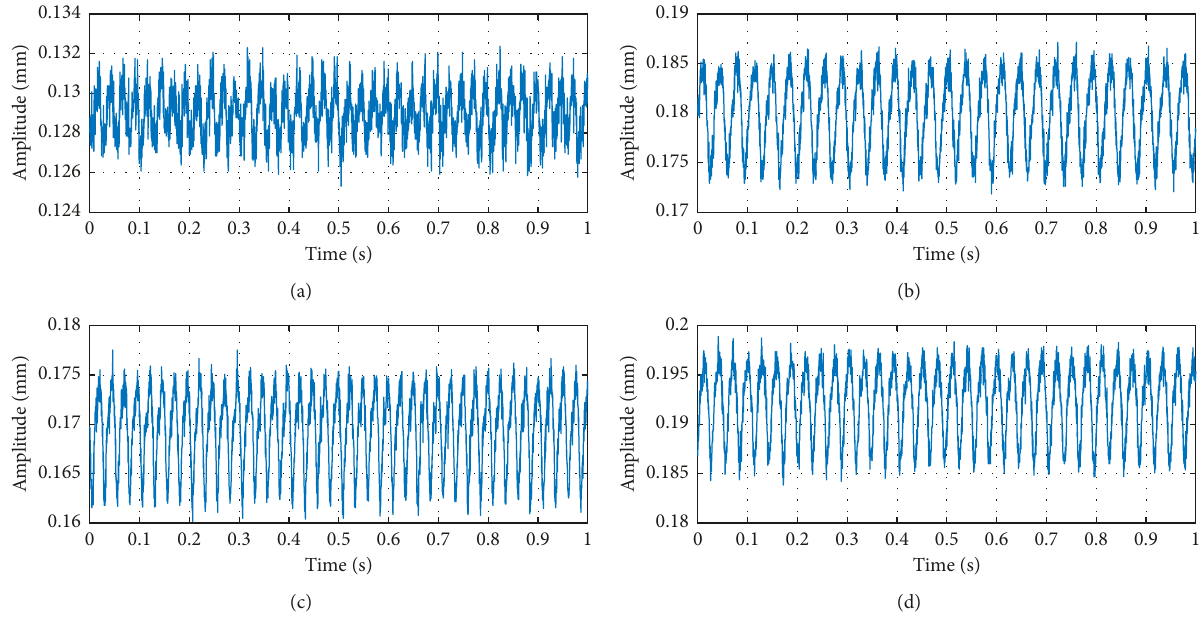
Figure 6: The time-domain of original vibration signals in 4 working